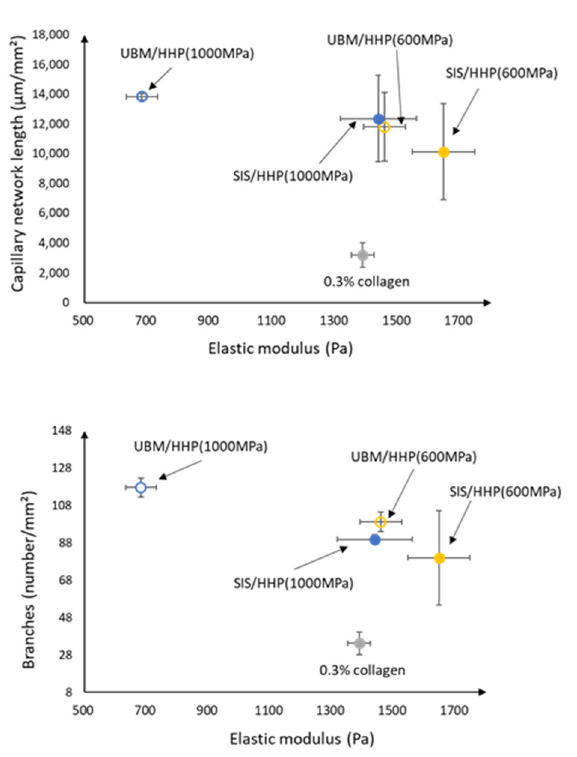
Figure 10. Correlation between matrix stiffness and each parameter of the capillary network structure formed on d-ECM hydrogels. HHP represents the method of decellularization of each tissue (urinary bladder matrix (UBM) and small intestine submucosa (SIS)).